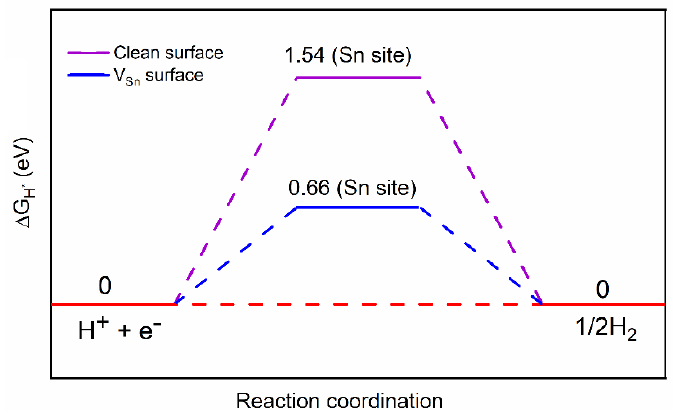
Figure 5. The adsorption Gibbs free energy of H adsorbed on the SnSe monolayer surface. Clean represents the clean SnSe monolayer surface. V Sn represents the SnSe monolayer surface with one Sn defect.